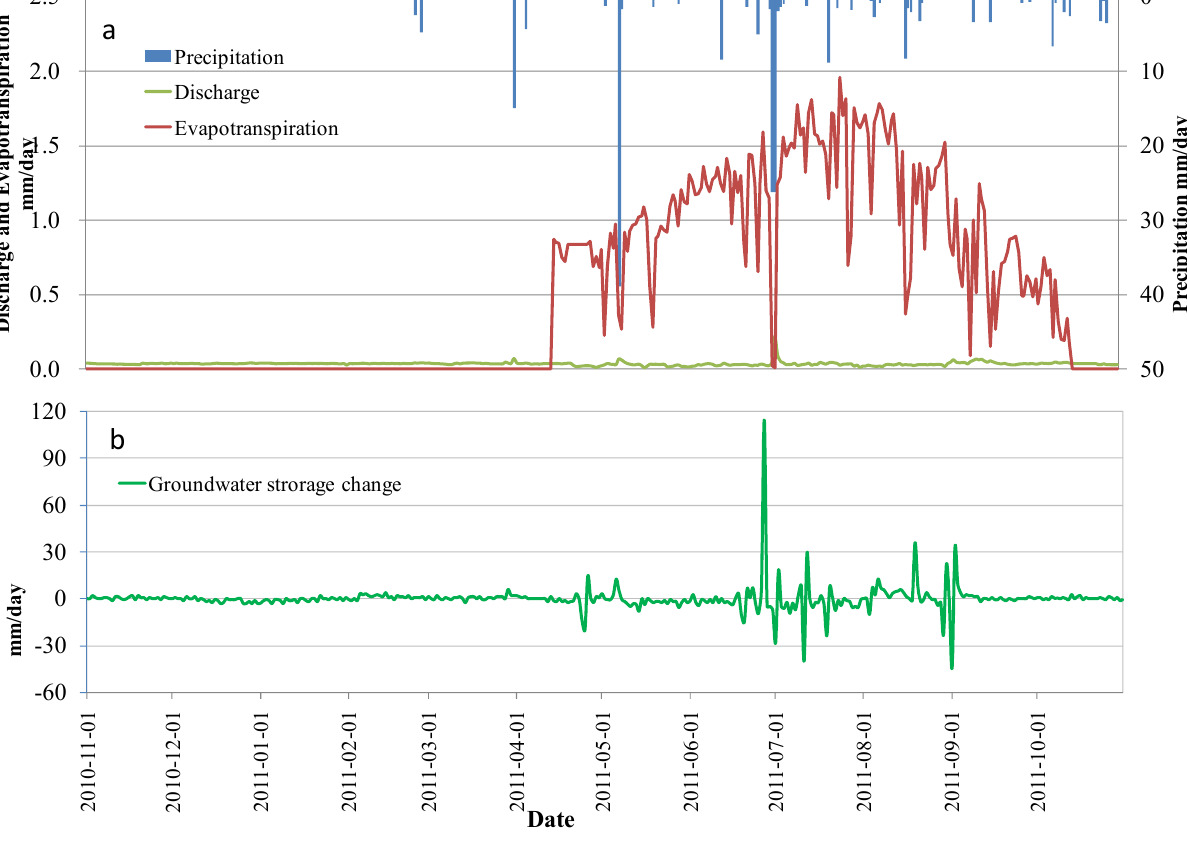
Figure 7. Average precipitation, river discharge, and estimated ET ( a ); groundwater storage change ( b ) in Bulang catchment from November 2010 to October